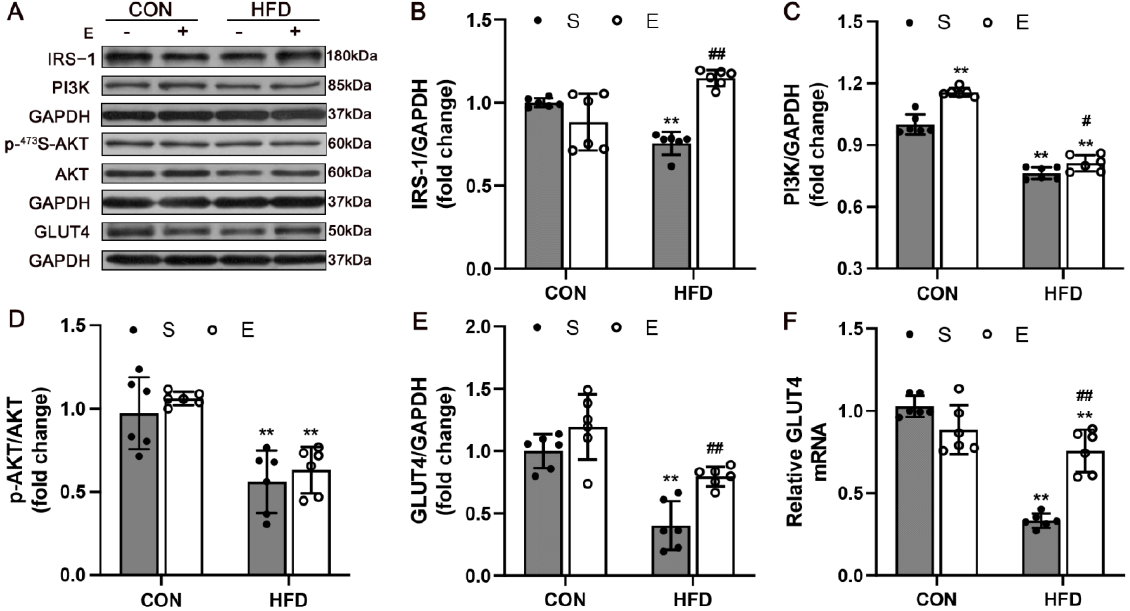
Figure 4. Aerobic exercise attenuated insulin resistance through the upregulation of IRS−- 1/PI3K/AKT signaling. ( A ) Western blot images and quantifications of muscle samples, including: ( B ) IRS−-1, ( C ) PI3K, ( D ) p-−AKT/AKT, and ( E ) GLUT4. ( F ) mRNA expression of GLUT4 in skeletal muscle. Values are expressed as the mean ± SD. CON, normal control; HFD, high-fat diet; S, seden- tary; E, exercise. * p < 0.05, ** p < 0.01 vs. NS group; # p < 0.05, ## p < 0.01 HS group. (n =